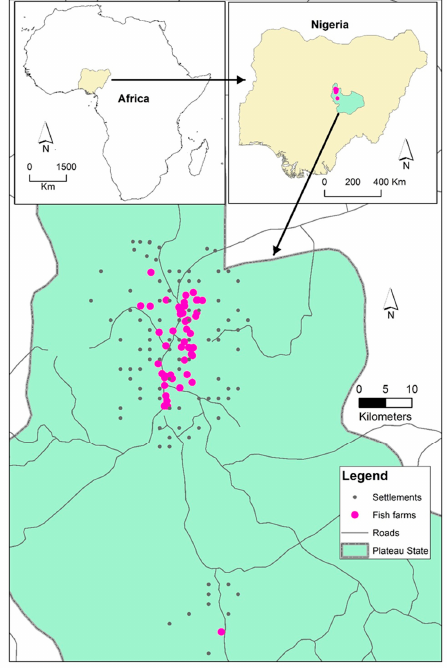
Figure 1. Spatial distribution of fish farms along main roads.